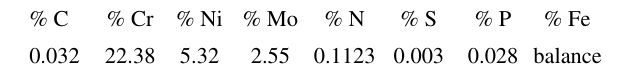
Table 1. Chemical analysis of the material (wt%). % C